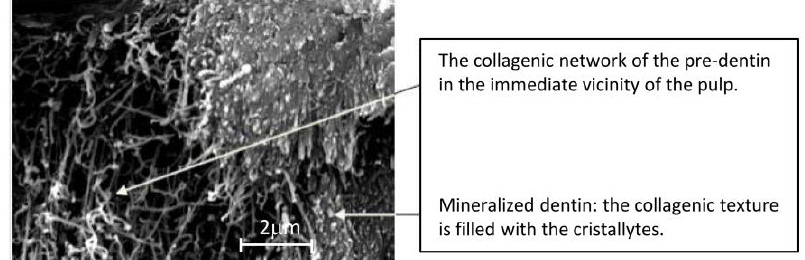
Figure 3. Dentin morphology with collagen fibers and inorganic components.